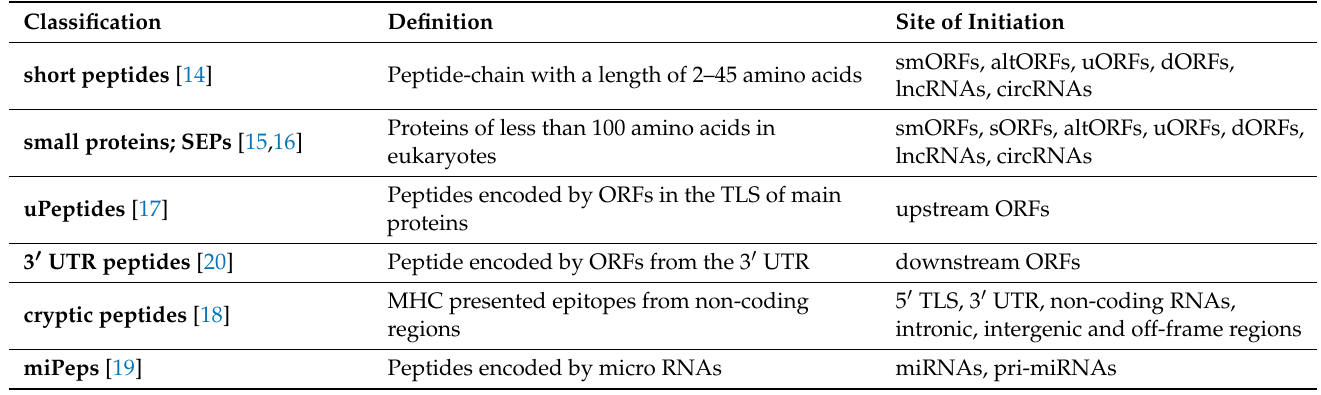
Table 1. Summary of the heterogeneous nomenclature and definition of non-canonical